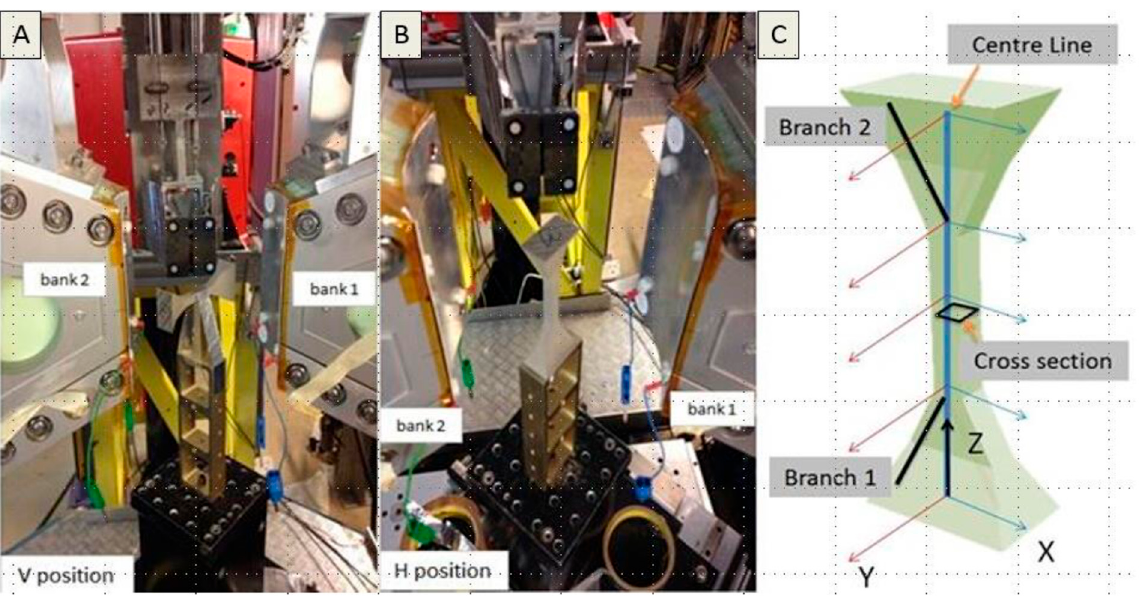
Figure 2. ( A ) and ( B ) measurement setup of ENGIN-X and ( C ) data collection strategy from the steel test peg. In Figure 3, residual strains along the centre line of the steel test peg are presented. Strains in the Z-direction are larger than those in other directions at the same positions; strain changes are associated with the change in cross section, and strains at the base near the base plate are much smaller than strains in the top of the sample.